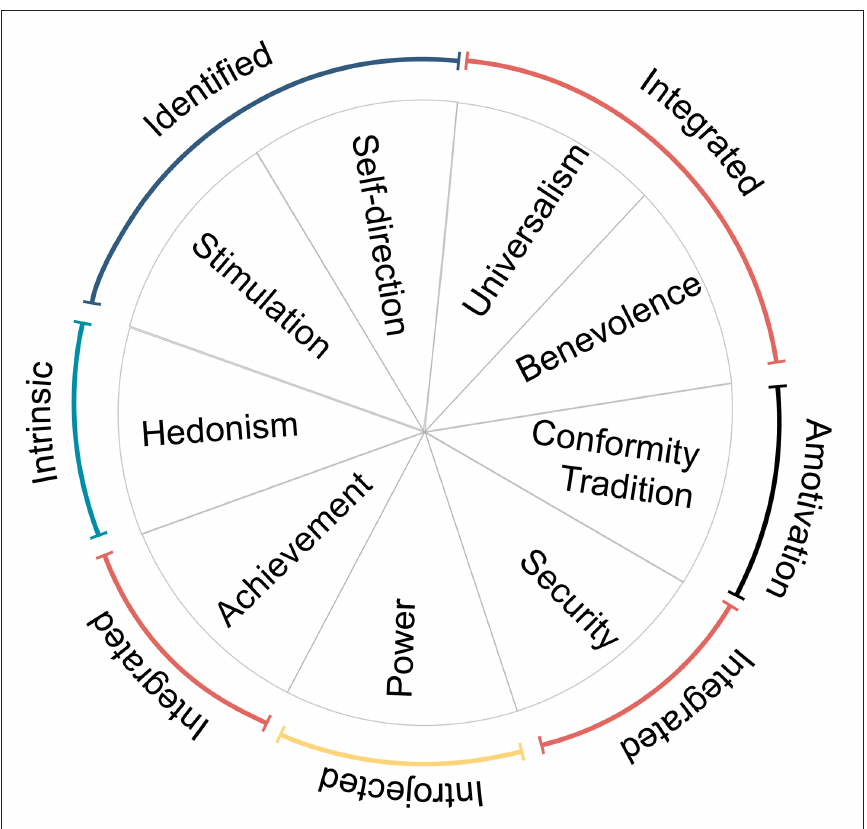
Figure 9: Interaction between values and motivations underlying participation among Järviwiki and Safecast